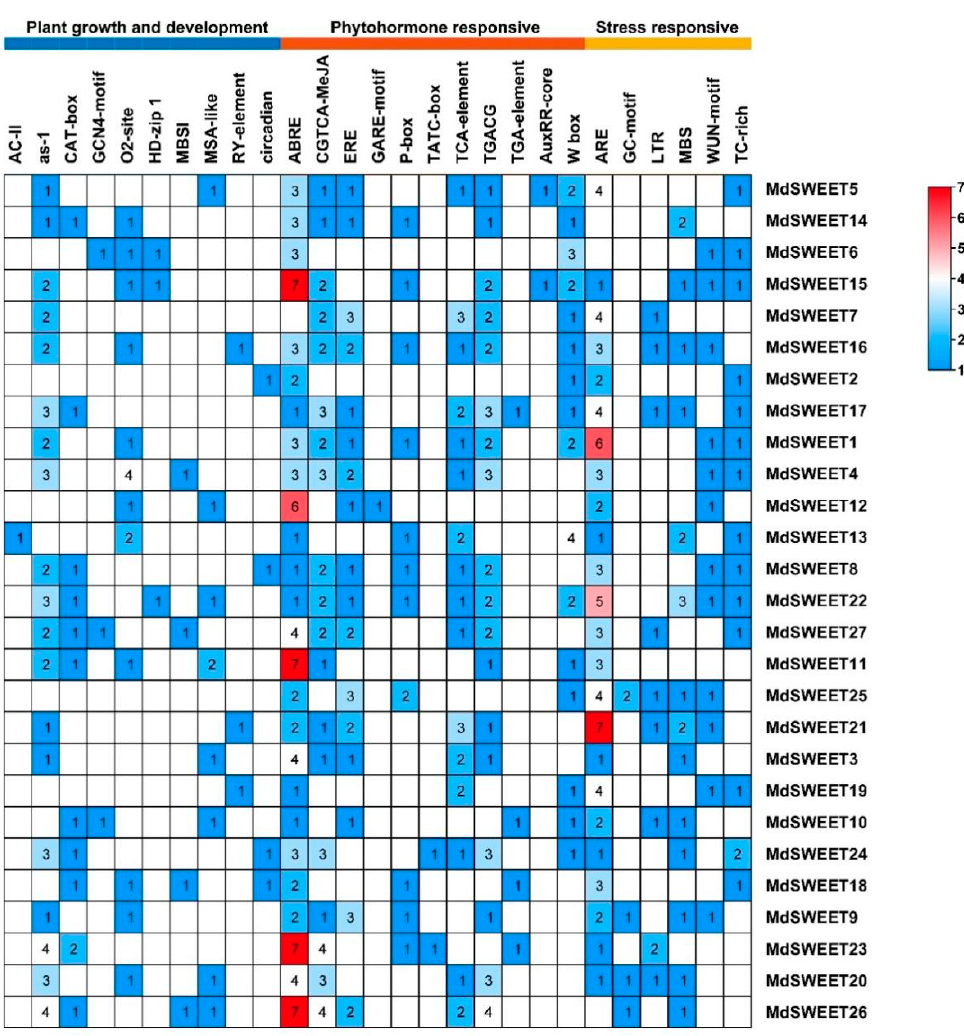
Figure 6. Analysis of cis-acting elements in the promoter regions of MdSWEET genes. The three common cis-acting elements identified were related to plant growth and development, phytohormone response, and stress response. AC-II, vascular bundle-specific expression element; as-1, phloem tissue-specific element; GCN4_motif, endosperm-specific expression element; O2-site, zein metabolism regulation element; HD-zip 1, palisade mesophyll cell-associated element; MBSI, flavonoid biosynthetic gene regulation element; MSA-like, cell cycle regulation element; RY-element, seed-specific regulation element, ABRE, abscisic acid-responsive element; ERE, eth- ylene-responsive element; GARE-motif, gibberellin-responsive element; W box, root-specific ex- pression element; ARE, anaerobic induction element; GC-motif, anoxic specific inducibility ele- ment; LTR, low-temperature responsive element; MBS, MYB binding site; WUN-motif, wound-responsive element; TC-rich, defense and stress responsiveness element. AC-II, as-1, GCN4_motif, O2-site, HD-zip 1, MBSI, MSA-like, RY-element, and circadian are involved in plant growth and development; ABRE, CGTCA-MeJA, ERE, GARE-motif, P-box, TATC-box, TCA-element, TGACG, TGA-element, and AuxRR-core are involved in hormone responses; ARE, GC-motif, LTR, MBS, WUN-motif, and TC-rich are involved in stress responses. The heatmap and color columns indicate the numbers of cis-acting elements. 3.7. Expression Patterns of MdSWEET Genes in Different Apple Tissues/Organs and Develop- mental Stages To comprehensively decipher the potential functions of MdSWEET s, the expression of 27 MdSWEET genes in different tissues/organs and developmental stages of apple was detected by qRT-PCR (Figure 7). The results showed that expression of MdSWEET genes